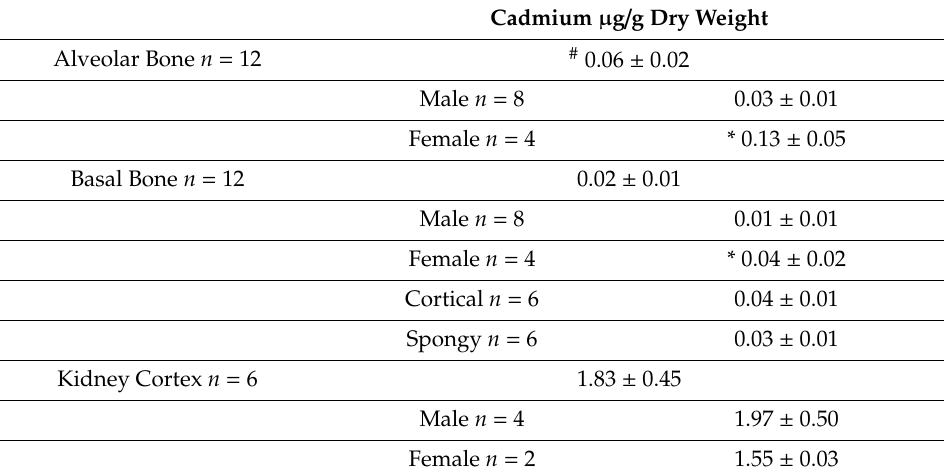
Table 1. Cadmium content of human cadaver samples subdivided by bone type and gender.